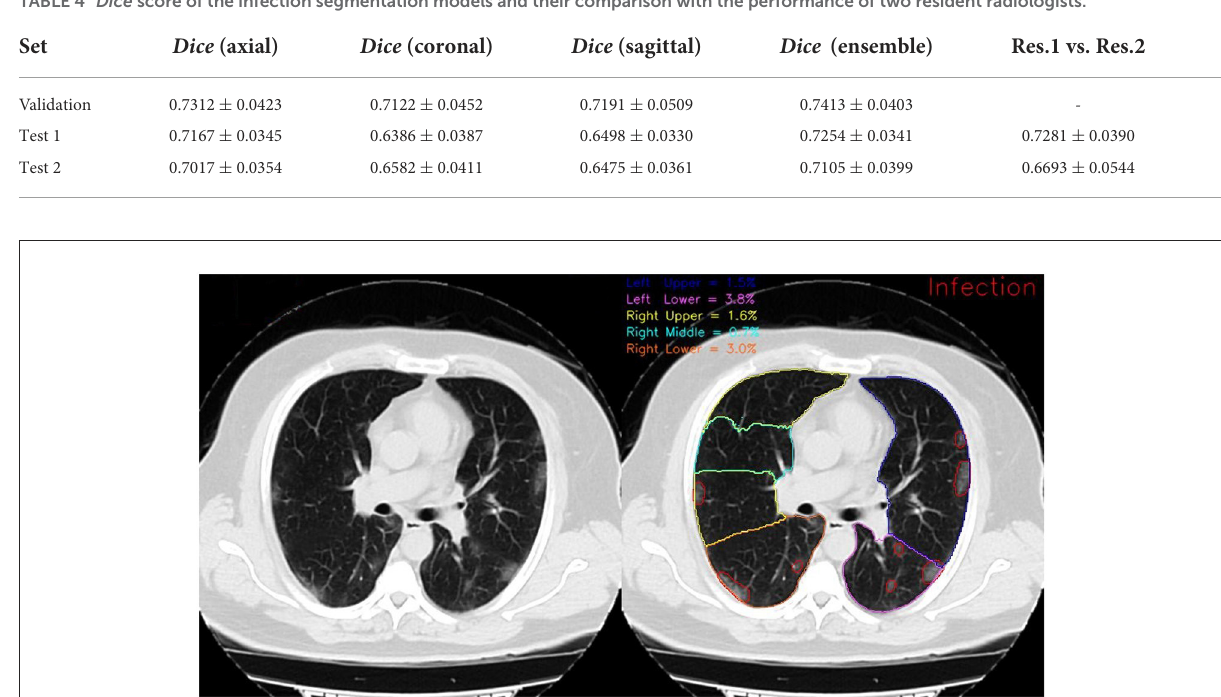
TABLE 4 Dice score of the infection segmentation models and their comparison with the performance of two resident radiologists.